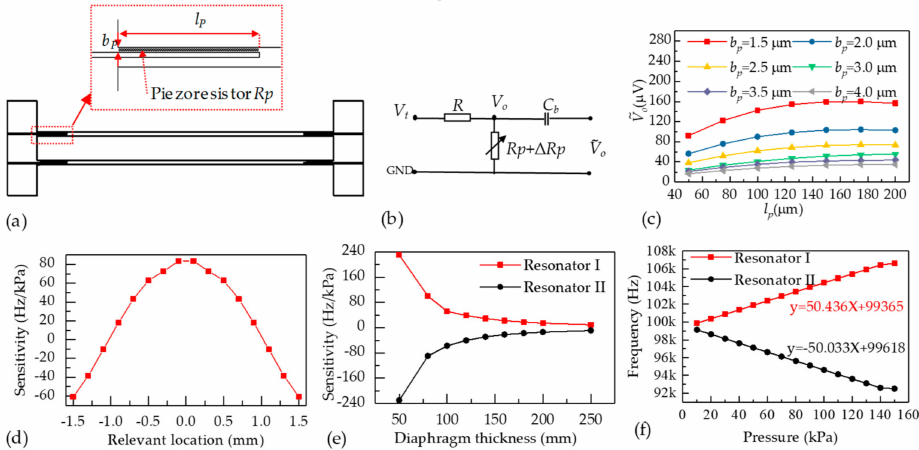
Figure 3. ( a ) The geometry of the DETF resonator using in simulations; ( b ) The electrical equivalent model of the signal detection; ( c ) output ac signal variances to the dimensions of piezoresitor; ( d ) the sensitivity variances to the relevant locations of the resonator with the thickness of the pressure sensitive diaphragm of 100 µ m; ( e ) the sensitivity variances to the thicknesses of the pressure sensitive diaphragm with the central beam locating at − 0.6 mm and side beam locating at 1.35 mm; and ( f ) the eigenfrequency responses to applied pressure in FEA